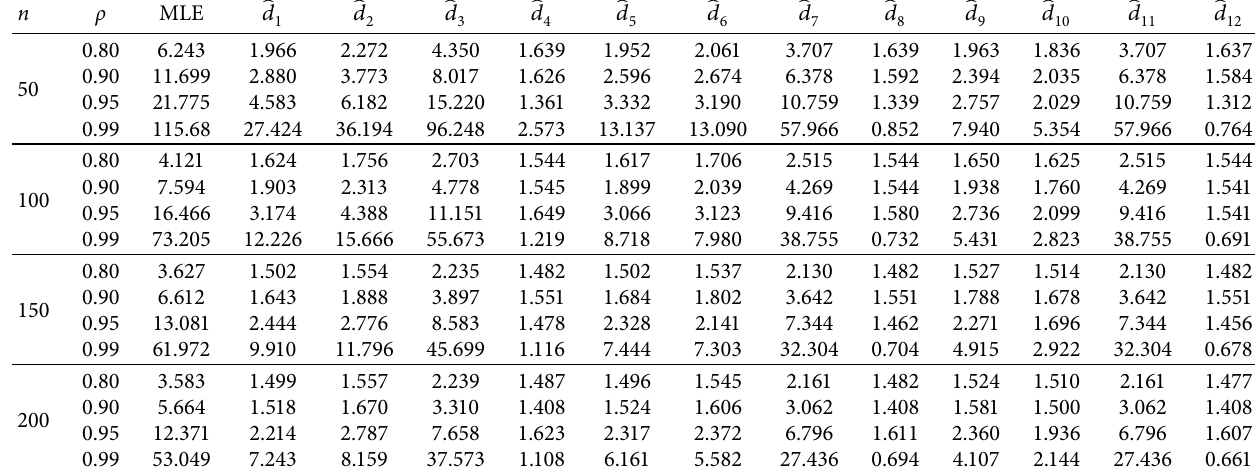
Table 4: Estimated MSEs of the COMPRM estimators, when p � 6 and ϑ � 0 . 85.